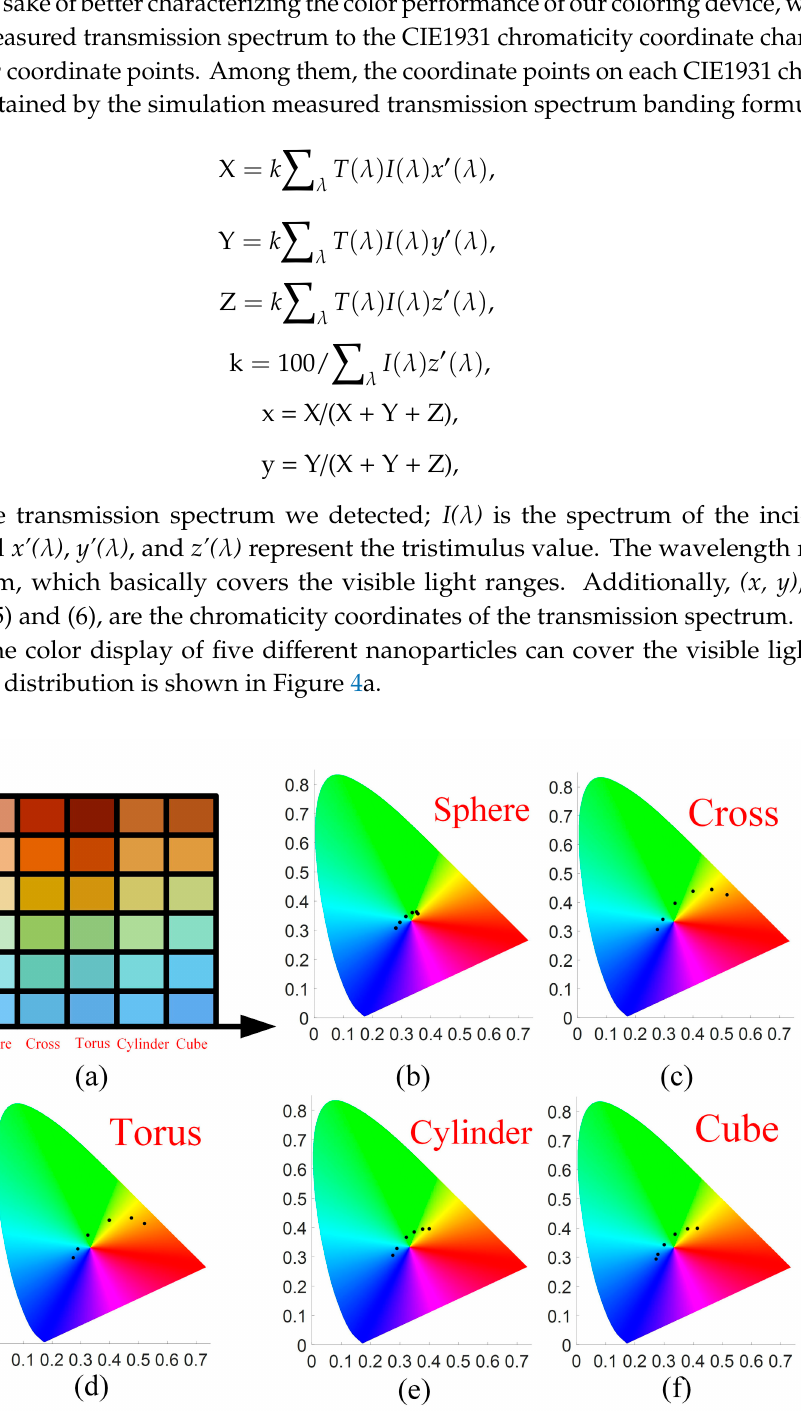
Figure4. ( a )Colordisplayofthedi ff erentnanoparticlesatdi ff erentgeometricparameters. ( b – f ) CIE1931 Figure 4. ( a ) Color display of the different nanoparticles at different geometric parameters. ( b – f ) color space inversion map distribution under di ff erent CIE1931 color space inversion map distribution under different conditions.